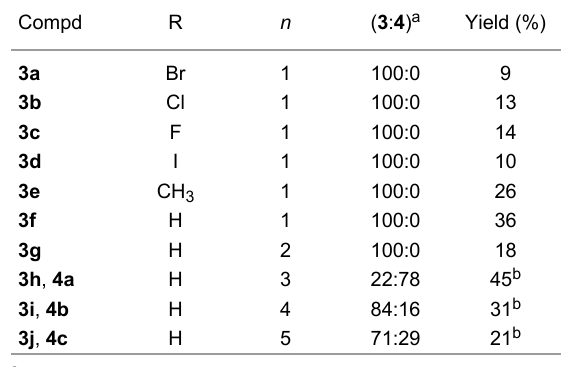
Table 1: Synthesis of thiolactone-isatin hybrids 3 and tetracycles 4 .